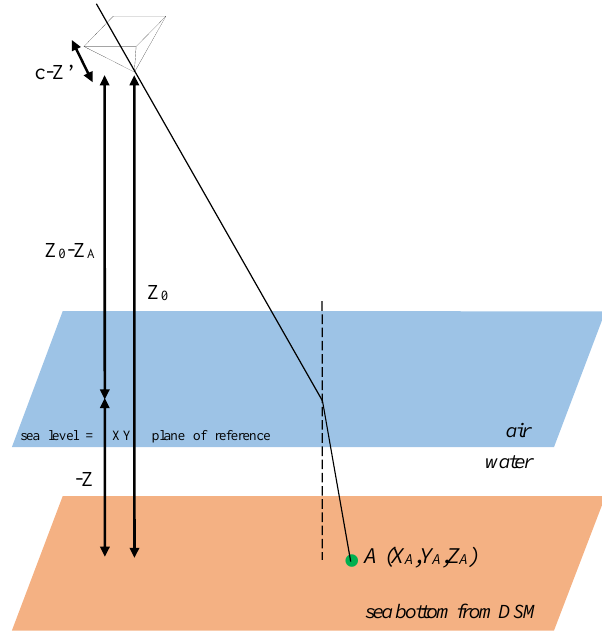
Figure 7. The percentage of the light ray in water and in air may only be approximated.